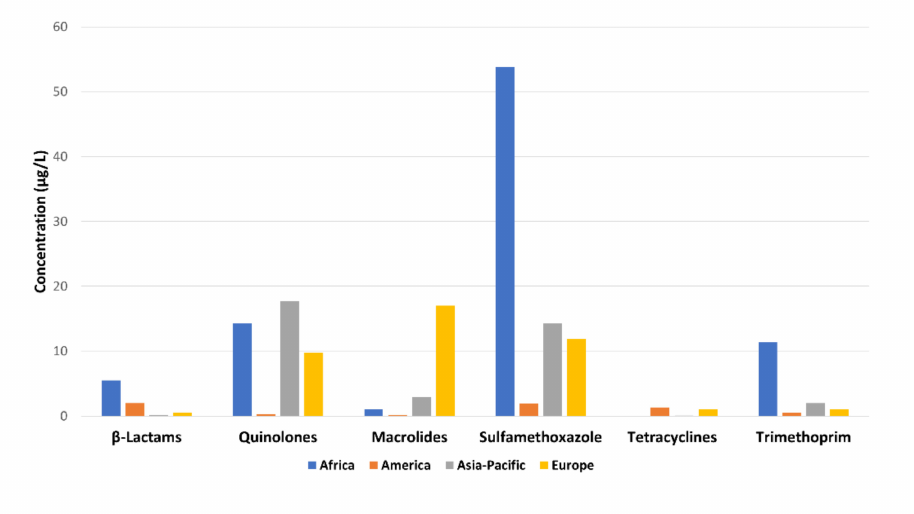
Figure 2. Antibiotics concentrations in surface waters across the world.